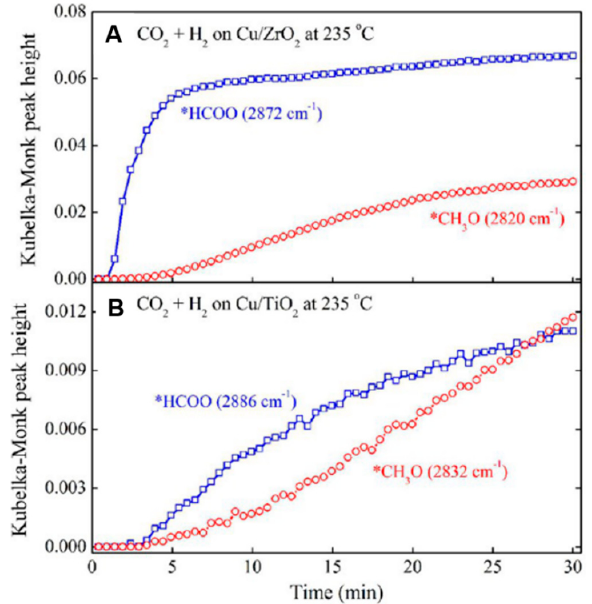
Figure 12. IR peak intensities of surface formate and methoxy species versus time during CO 2 +H 2 reaction over (a) Cu/ZrO 2 and (b) Cu/TiO 2 catalysts. (Reaction conditions: 5 mL/min CO 2 + 15 mL/min reaction over ( A ) Cu / ZrO 2 and ( B ) Cu / TiO 2 catalysts. (Reaction conditions: 5 mL / min CO 2 + 15 mL / min H 2 , 0.1 MPa, 235 °C). Reprinted with permission from Reference [61]. Copyright 2016, American H 2 , 0.1 MPa, 235 ◦ C). Reprinted with permission from Reference [61]. Copyright 2016, American Chemical Society. Chemical